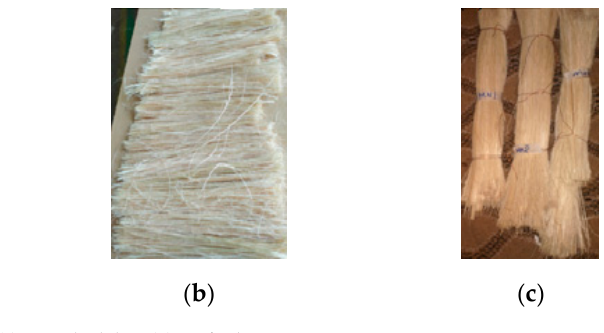
Figure 3. ( a ) Injibara, ( b ) Kombolcha, ( c )